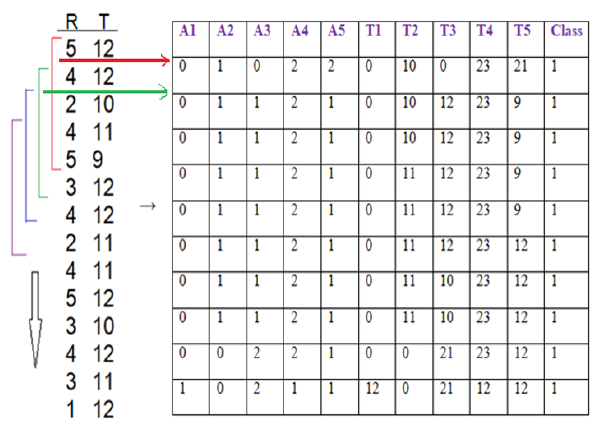
Figure 4. Data array and windowing logic.